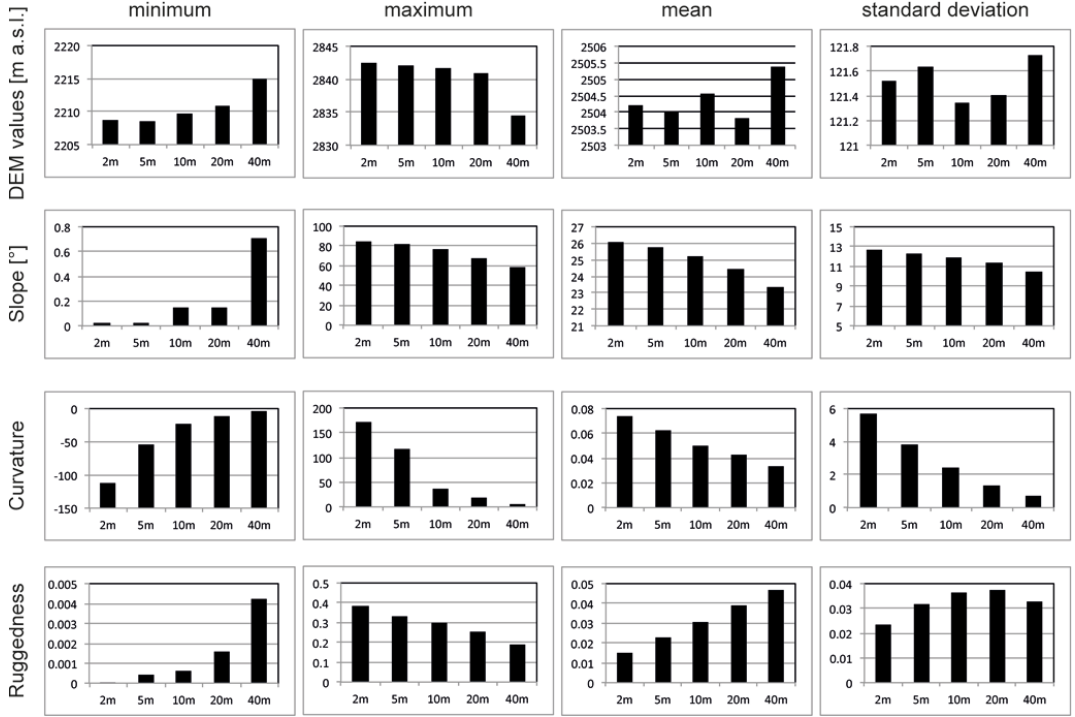
Fig. 6. Statistical comparison of the used DEM resolutions 2m, 5m, 10m, 20m and 40m for DEM values, slope, curvature and ruggedness covering the area Weissfluhjoch pictured in Fig. 4.